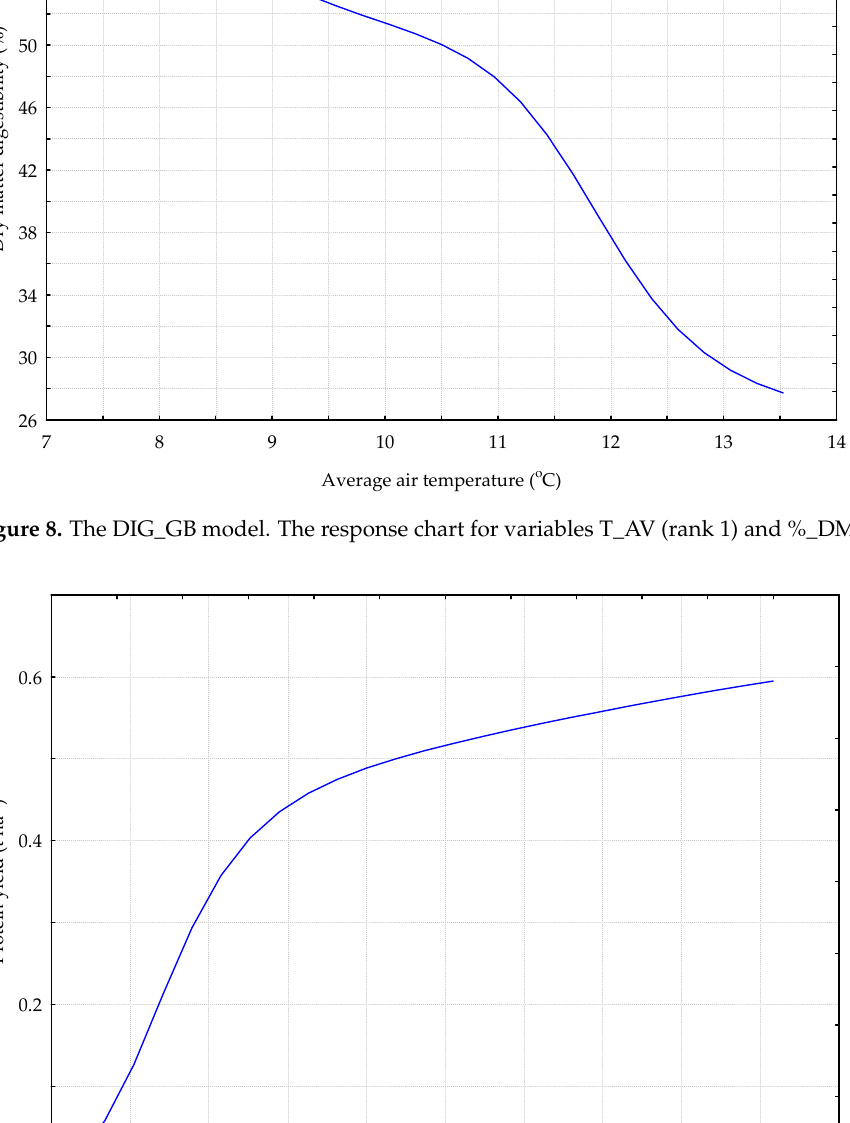
Figure 9. The P_GB model. The response chart for variables PREC_S (rank 1) and P_Y. The relation between the yield of dry matter from the sward with the predominance of grasses and red clover (Y_GB model) and the average daily air temperature (T_AV) is shown on Figure 10. The average daily air temperature in the period ranging from the spring onset of vegetation to the harvest date stimulated the yield of dry matter from the sward with the predominance of grasses and red clover.